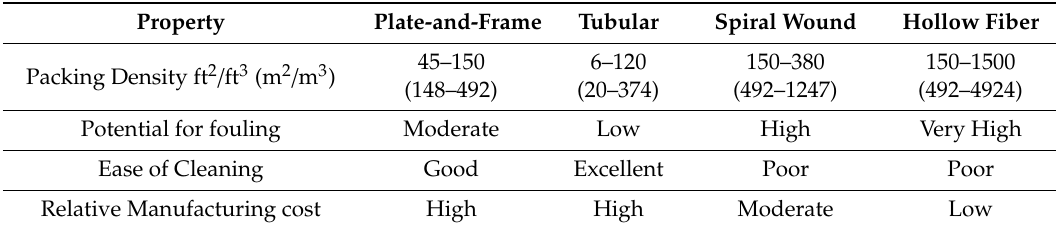
Table 7. Basic properties of various membrane modules (Adapted from